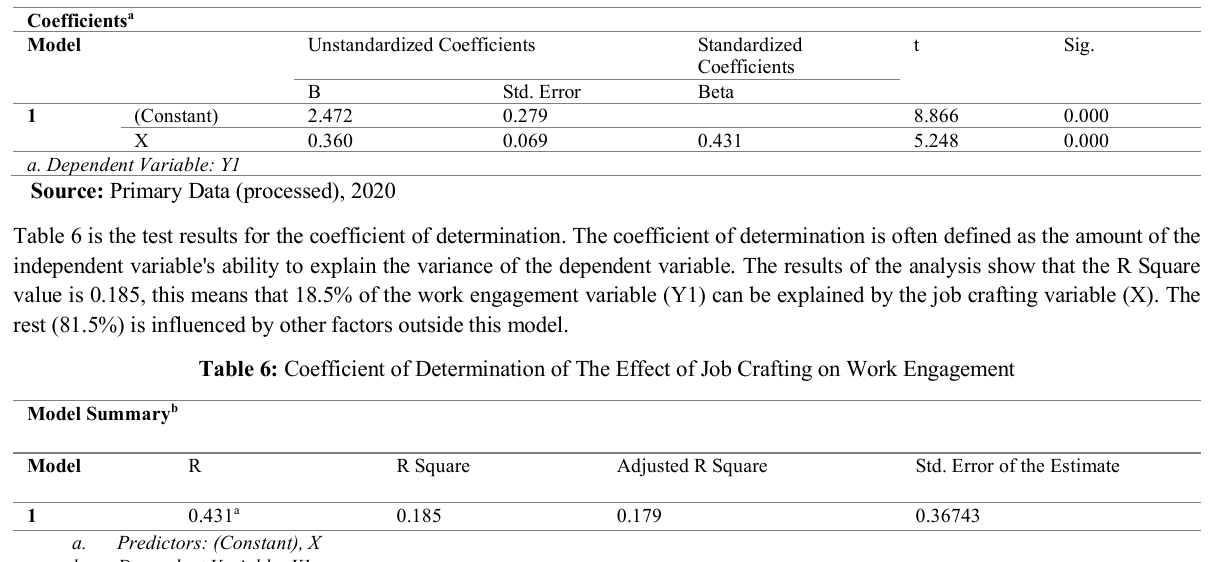
Table 5: Effect of Job Crafting on Work Engagement